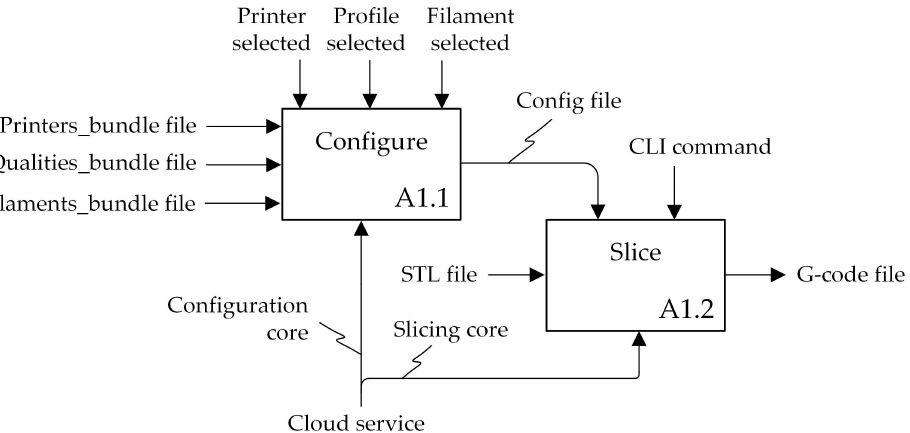
Figure 3. IDEF0 of the whole slicing process (configure and